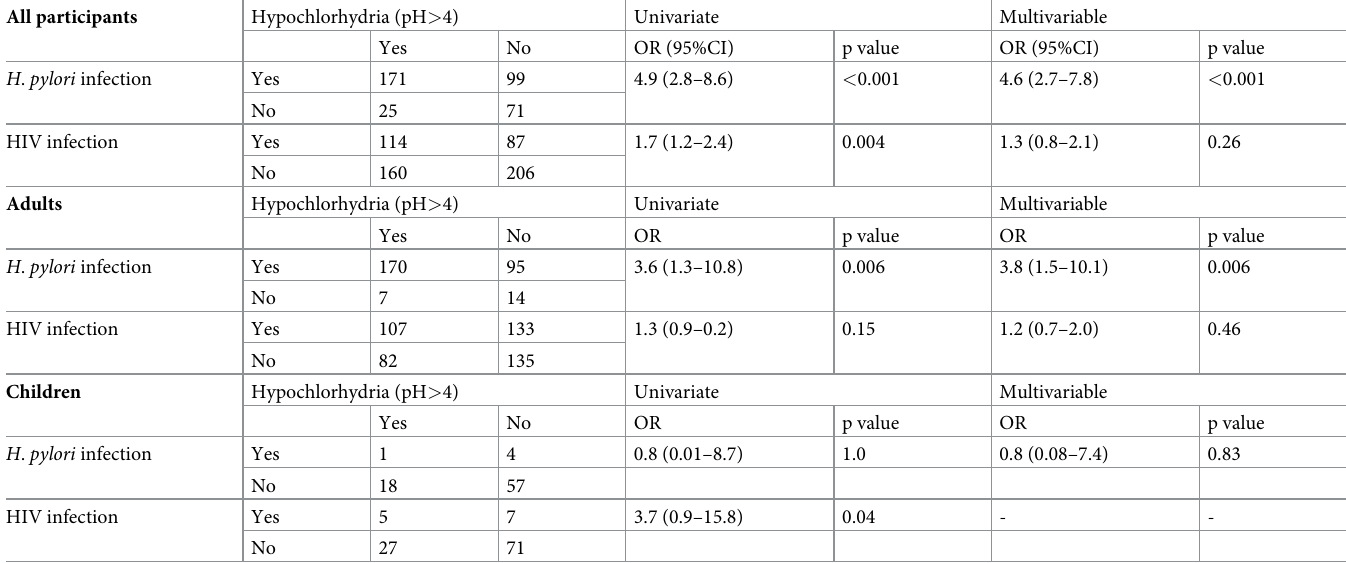
Table 3. Logistic regression analysis by infection with H . pylori or